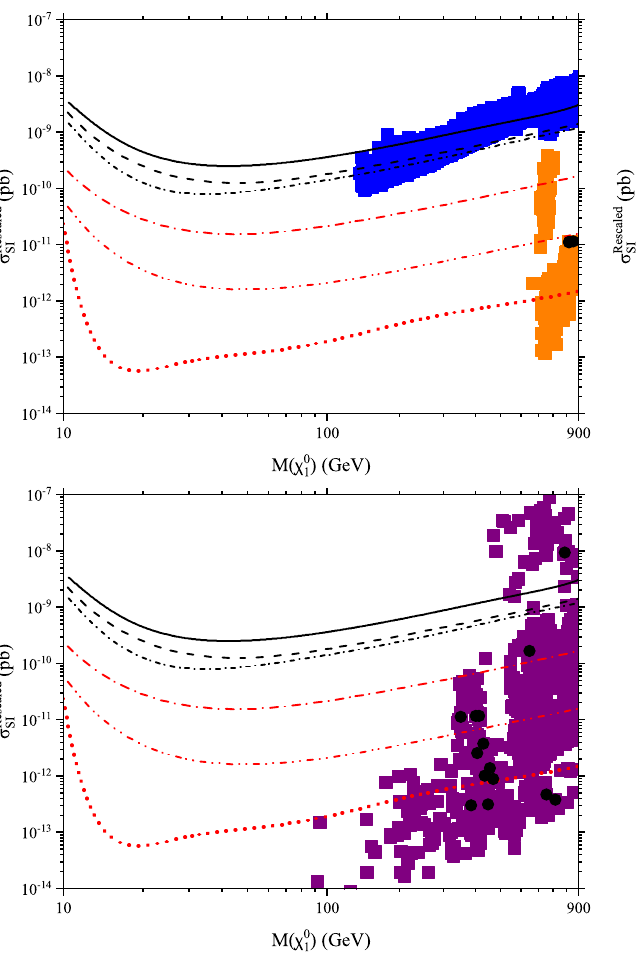
Fig. 4 Illustration of the PandaX-II, LUX, and XENON WIMP- nucleonspin-independentcross-sectionconstraintsappliedtothemodel space studied in this work. The σ SI cross-sections have been rescaled in accordance with Eq. (17). All points plot satisfy the light Higgs boson mass and relic density observations we outlined in this work,